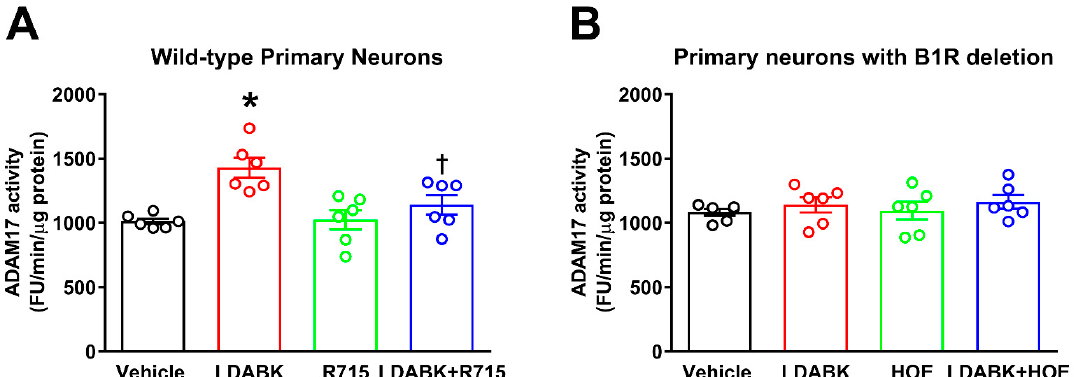
Figure 2. Effect of B1R activation on ADAM17 activity in primary hypothalamic neurons. ( A ) Incubation of wild-type neurons with B1R-specific agonist Lys-Des-Arg 9 -Bradykinin (LDABK) significantly increased ADAM17 activity. Pre-treat- ment with R715, a B1R-specific antagonist, prevented this LDABK-mediated increase in ADAM17 activity. R715 treatment alone did not have any effect on ADAM17 activity. ( B ) Treatment with LDABK did not show any effect on ADAM17 activity in neurons with B1R deletion. In addition, the HOE 140, a kinin B2 receptor (B2R)-specific antagonist also did not show any effect on ADAM17 activity. The cultured primary neurons were pre-treated with a specific B1R antagonist (R715, 10 μ M) or a specific B2R antagonist HOE 140 (HOE, 10 μ M) for 1 h, followed by treatment with LDABK (300 nM) for 18 h ( n = 6 independent cultures/group). Statistical significance: one-way ANOVA followed by Tukey’s multiple comparisons test. * p < 0.05 compared to vehicle, † p < 0.05 compared to LDABK.